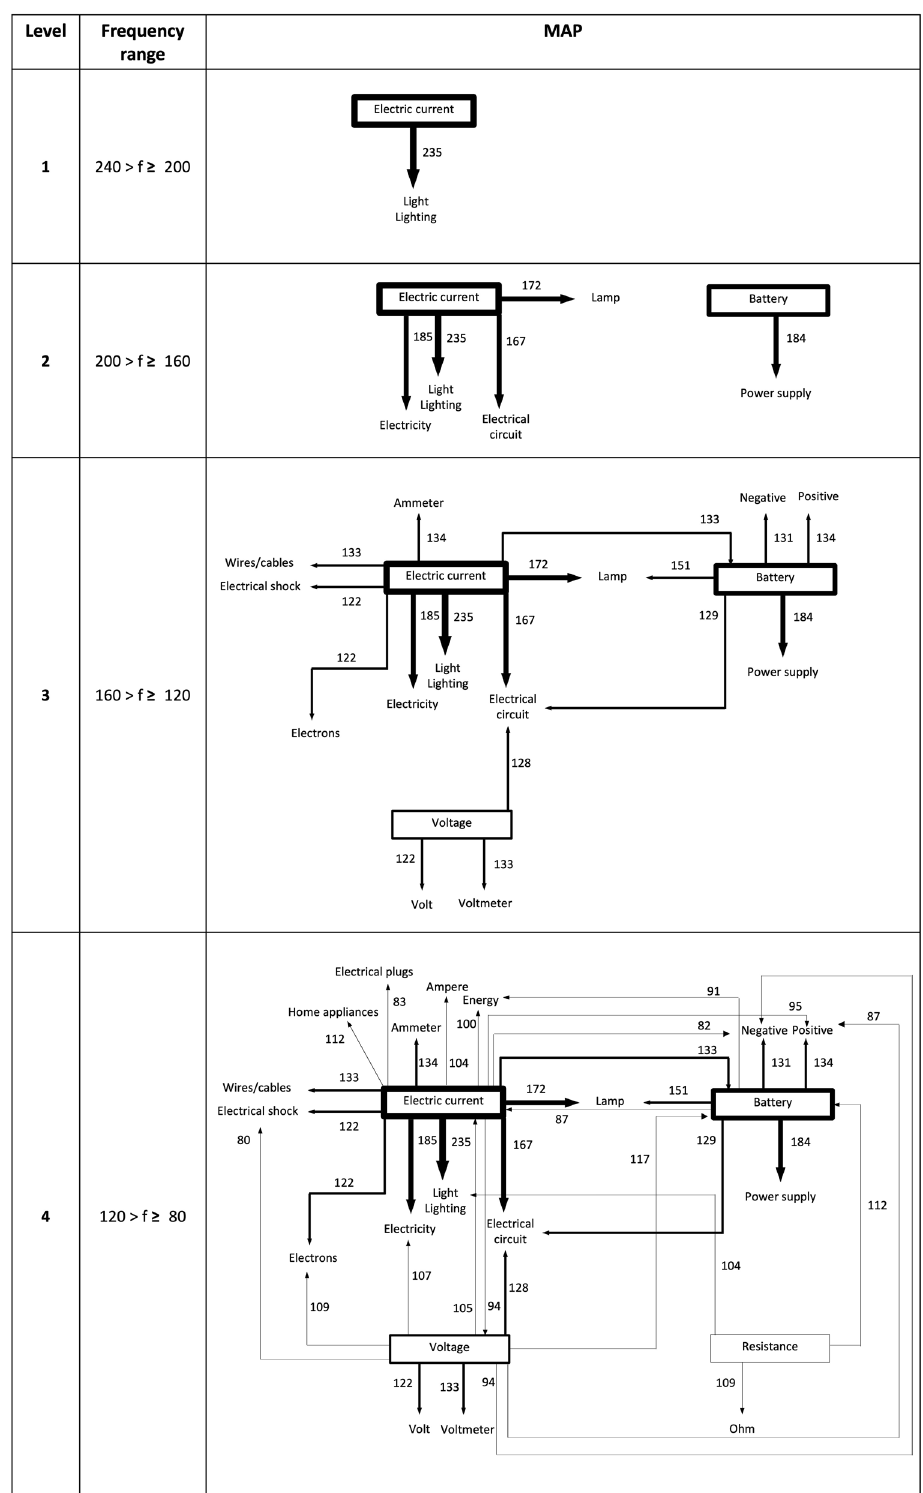
Fig. 4 Map of students’ cognitive structures at M2 (experimental